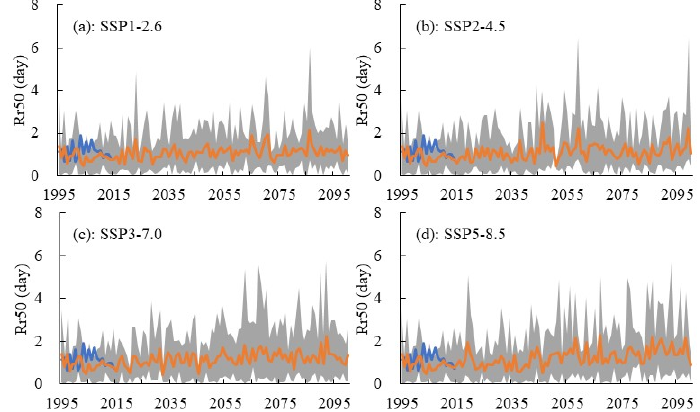
Figure 6. Historical variation and projection trend of Rr50 under SSPs scenarios (a to d represent